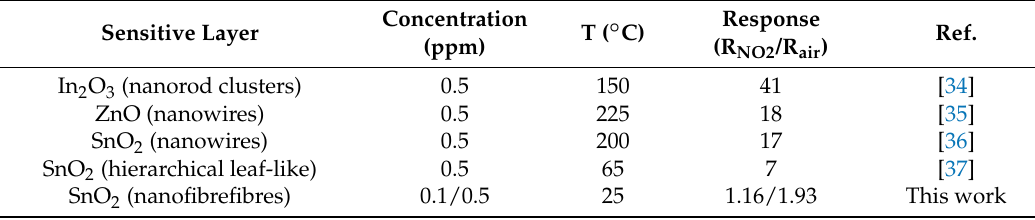
Table 4. Comparison of NO 2 -resistive gas sensors based in nanostructured